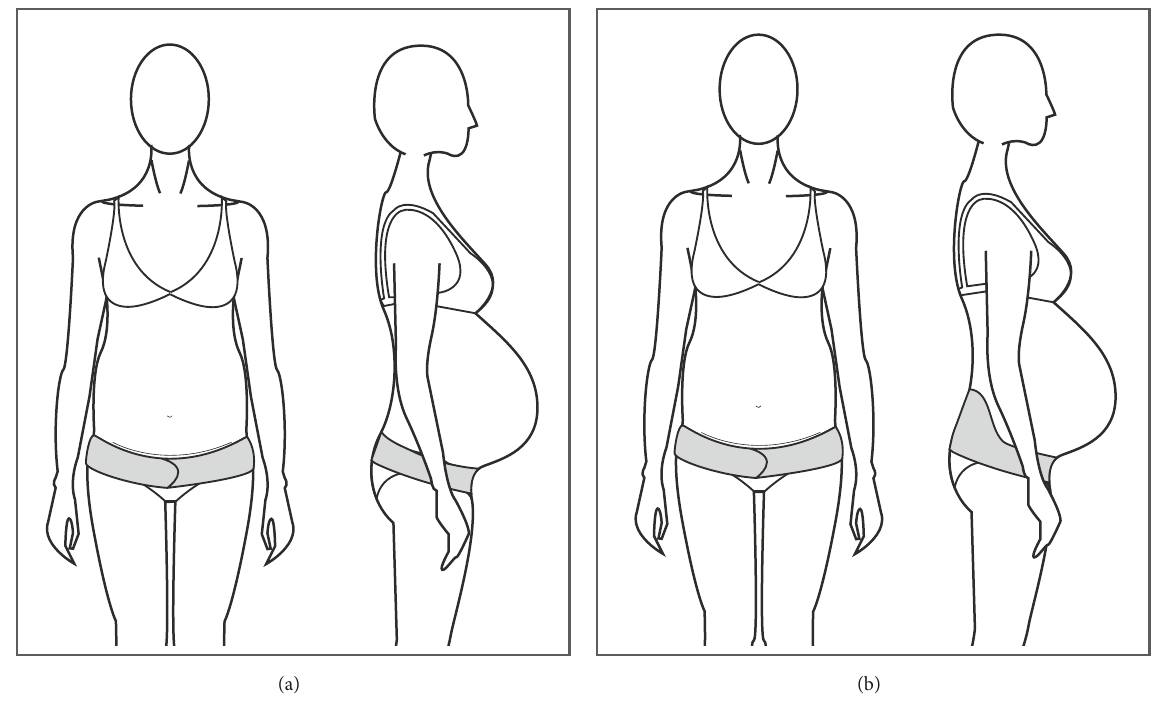
Figure 1: (a) Single panel belt. (b) Wide back